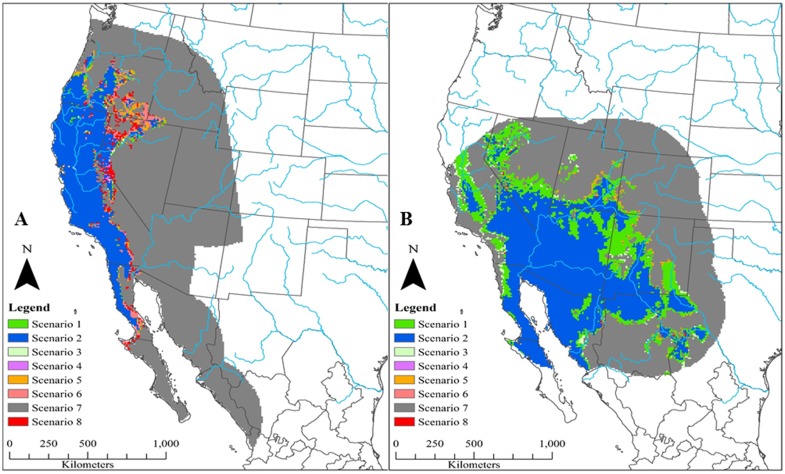
Future predicted changes in distributions of California quail (Callipepla californica; a) and Gambel’s quail (Callipepla gambelii; b) projected to 2070 and based on ensemble forecasts (estimated through Maxent) at 90% agreement.Major rivers of North America (blue lines) are included for geographic reference. Full descriptions for possible distribution conditions are given in Table 2. In short, distribution conditions represent: condition 1 (distribution expansion from current to 2050 and remaining suitable from 2050 to 2070), condition 2 (suitable at current and through all time periods), condition 3 (unsuitable from current to 2050 but expanding from 2050 to 2070), condition 4 (distribution contraction from current to 2050 but expanding from 2050 to 2070), condition 5 (distribution expansion from current to 2050 but contracting from 2050 to 2070), condition 6 (suitable from current to 2050 but contracting from 2050 to 2070), condition 7 (unsuitable at current and through all time periods), and condition 8 (distribution contraction from current to 2050 and remaining unsuitable from 2050 to 2070).